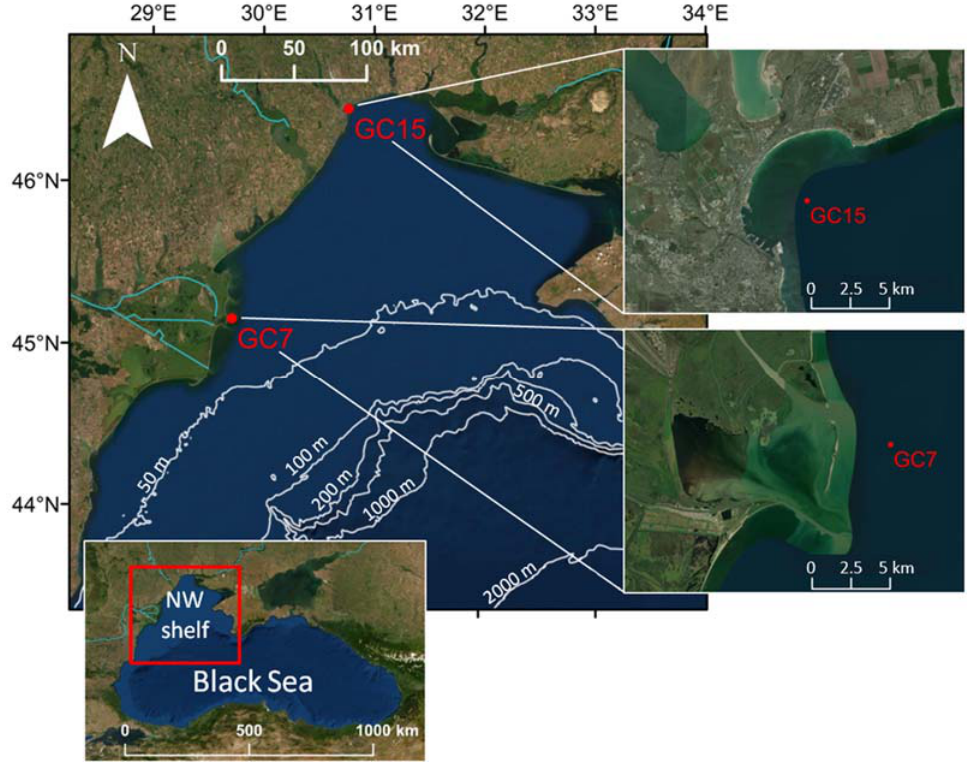
Figure 2. Locations of the gravity cores and multicores, GC7 and MC7 in front of the Danube mouth (45°12 ′ N, 29°48 ′ E) and GC15 and MC15 in the Odessa Bay (46°31 ′ N, 30°47 ′ E).